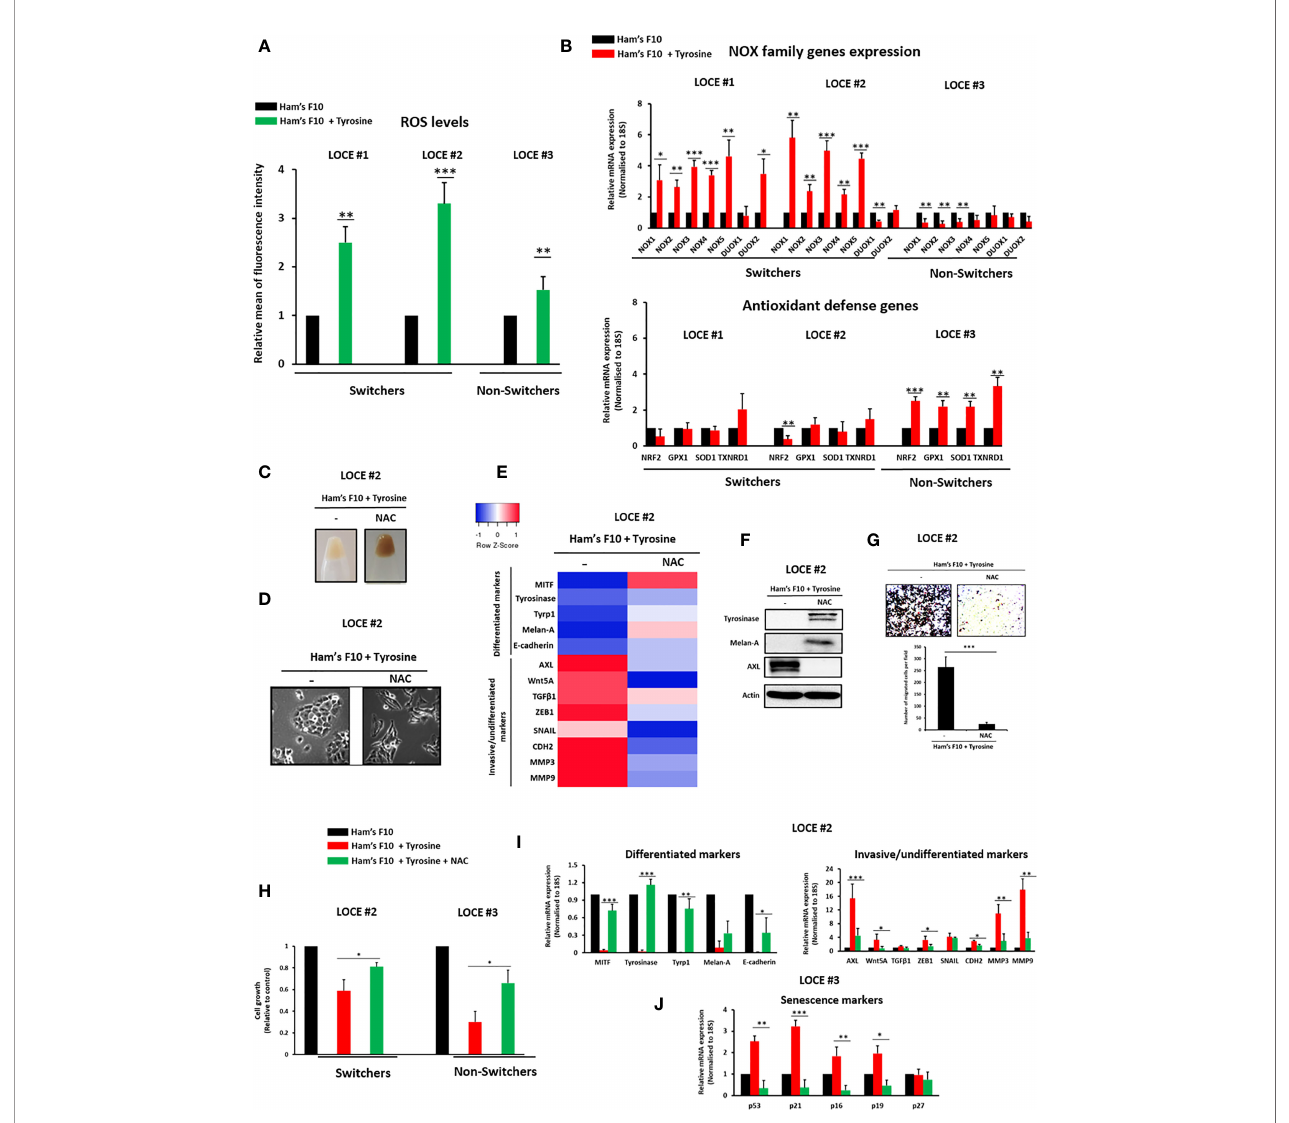
FIGURE 4 | ROS are driver of tyrosine-induced phenotypic switching. (A) ROS levels were measured using CellROX-Green fl ow cytometry assay in the switcher primary melanoma cultures (LOCE #1 and 2) and the non-switcher primary culture (LOCE #3) in the two culture media (Ham ’ s F10 and Ham ’ s F10 supplemented with tyrosine). Relative ROS levels are plotted. (B) Relative mRNA expression by Real-time quantitative PCR of the NOX family (NOX1-NOX5; DUOX1 and 2) and main anti-oxidant defense genes (NRF2, GPX1, SOD1, and TXNRD1) in switcher primary cultures (LOCE #1 and 2) and non-switcher primary culture (LOCE #3) in the two culture media (Ham ’ s F10 and Ham ’ s F10 supplemented with tyrosine) (Fold change was calculated based on gene expression in Ham ’ s F10 supplemented with tyrosine relative to Ham ’ s F10 and normalized to 18S). (C – G) Restoring the differentiated phenotype by ROS scavenger N-Acetyl-L-cysteine (NAC) in primary culture established in high tyrosine medium (below passage 8). (C) , Comparison of visible pigmentation of cell pellets and (D) , cell morphology within the switcher primary culture (LOCE #2 in high-tyrosine medium) after 14 days with or without 3 mM NAC. (E, F) (E) Heatmap of gene expression levels (average signature Z scores) for representative markers of the differentiated and invasive states (rows) and (F) protein expression (representative western blot) of the most discriminative markers of the differentiated (tyrosinase and Melan-A) and the invasive (AXL) phenotypes within the switcher primary culture (LOCE # 2 in high-tyrosine medium) after 14 days with or without 3 mM NAC (columns). (G) Effect of NAC on cell migration activity induced by tyrosine in primary culture (LOCE #2 in high-tyrosine medium). Upper panel show representative regions of the chamber fi lters with crystal violet-stained cells. The number of migrated cells per fi eld was calculated from three independent experiments. (H – J) Prevention of phenotypic switch using ROS scavenger NAC (from passage 1). (H) Relative cell growth within switcher primary culture (LOCE #2) and non-switcher primary culture (LOCE #3) propagated in culture medium with low tyrosine (Ham ’ s F10) or high tyrosine (Ham ’ s F10+ tyrosine) in the presence or the absence of NAC after 14 days. (I) Relative mRNA expression of main differentiated (green), invasive markers (red) days within switcher primary culture (LOCE #2) propagated in culture medium with low tyrosine (Ham ’ s F10) or high tyrosine (Ham ’ s F10+ tyrosine) in the presence or the absence of NAC after 14 days. (J) Relative mRNA expression of main senescence markers within the non-switcher primary culture (LOCE #3) propagated in culture medium with low tyrosine (Ham ’ s F10) or high tyrosine (Ham ’ s F10+ tyrosine) in the presence or the absence of NAC after 14 days (Fold change was calculated based on gene expression in Ham ’ s F10 supplemented with tyrosine relative to Ham ’ s F10). Data are presented as means ± SEM from from three independent experiments (*p < 0.05; **p < 0.01; ***p < 0.001,